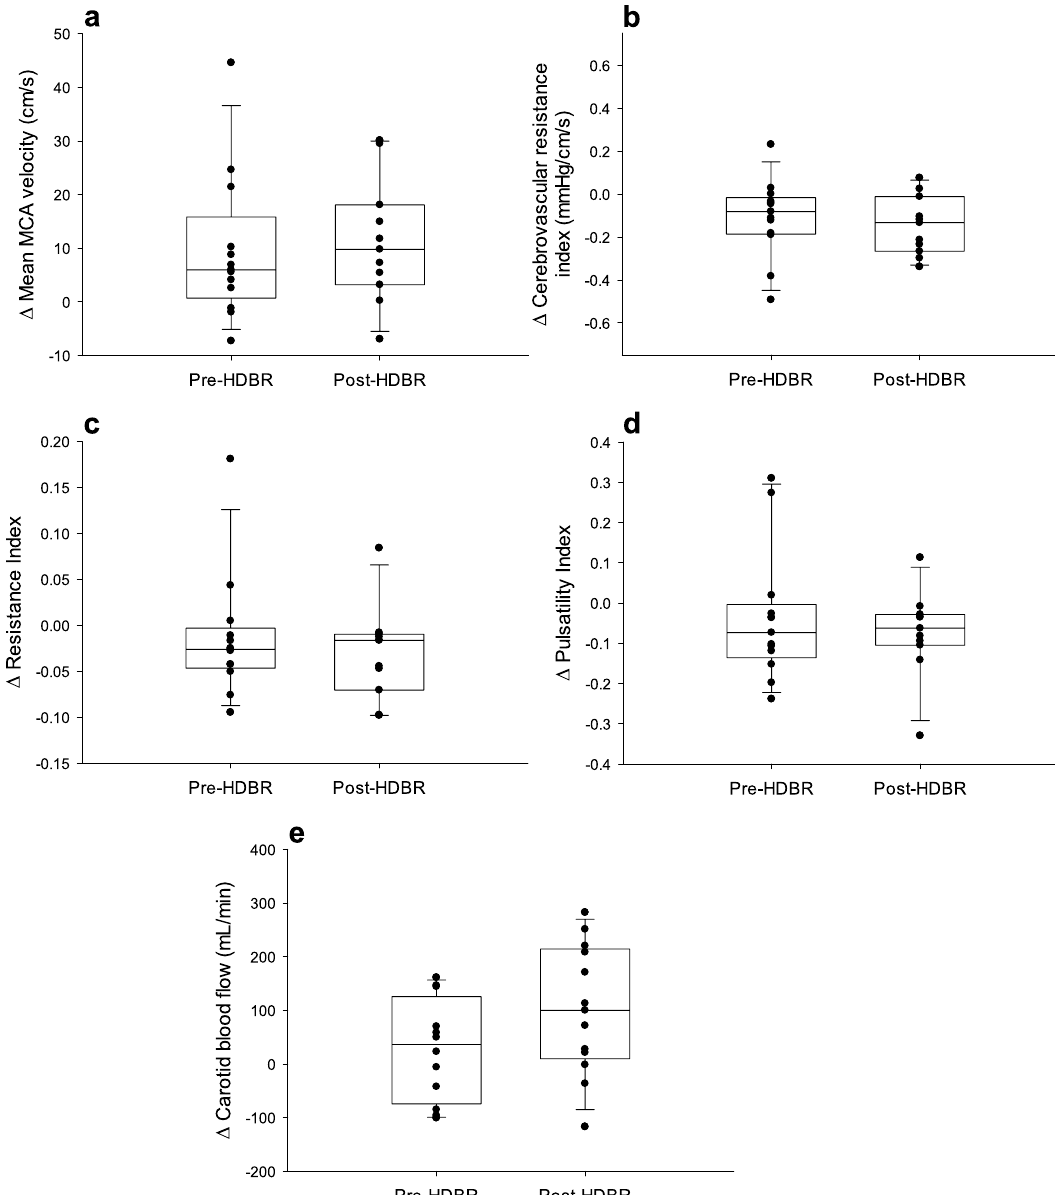
Figure 3. Change in middle cerebral artery mean velocity (a) , cerebrovascular resistance index (b) , resistance index (c) , pulsatility index (d) , and common carotid artery flow (e) from baseline to 5 min hypercapnia. The line within each box indicates the median, whereas the lower and upper boundaries indicate the 25th and 75th percentiles. Lower and upper whiskers represent the 10th and 90th